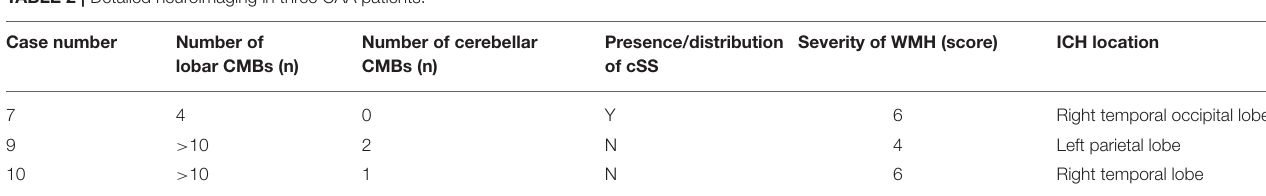
TABLE 2 | Detailed neuroimaging in three CAA